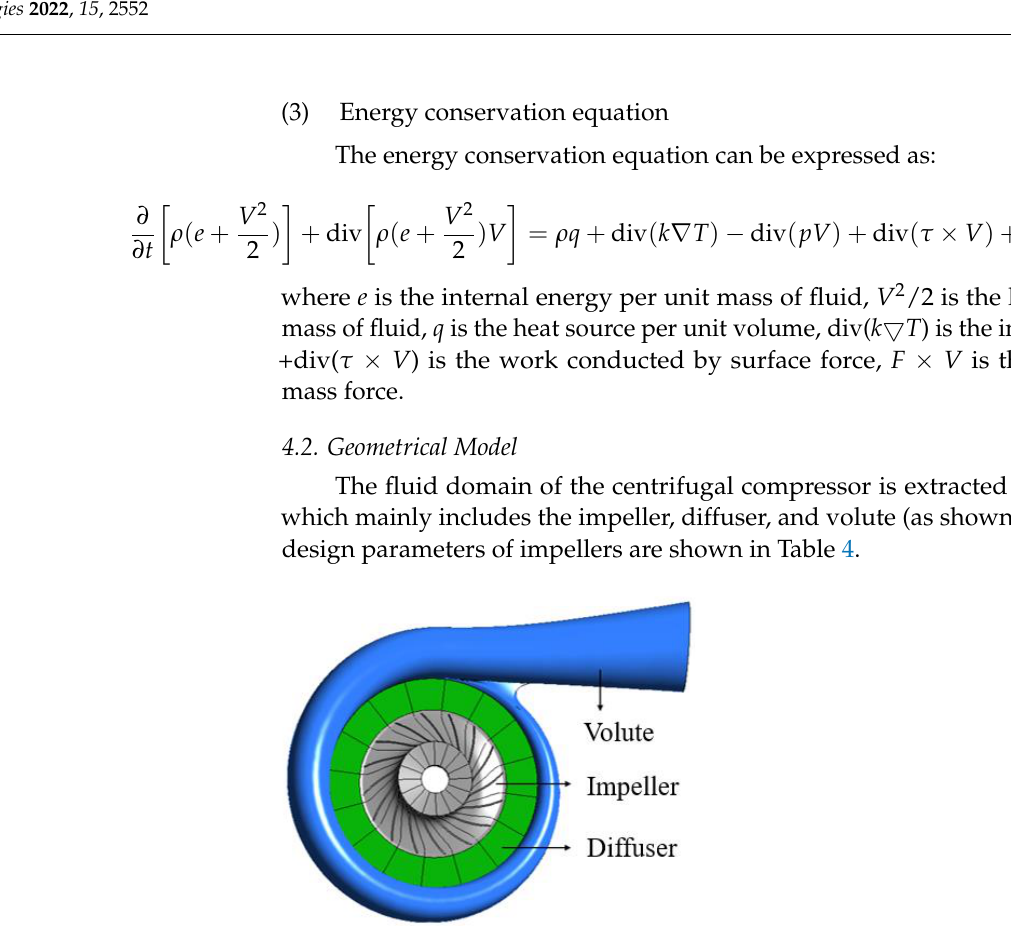
Figure 3. Model of impeller, diffuser, and volute. Table 4. Main design parameters of centrifugal